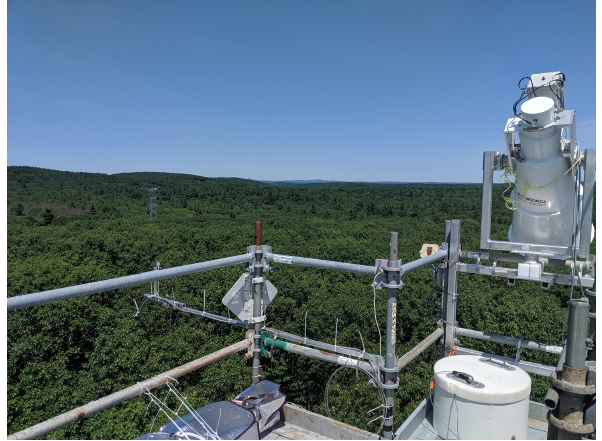
Figure 1. Radiometer setup at the Harvard Forest hardwood walk- up